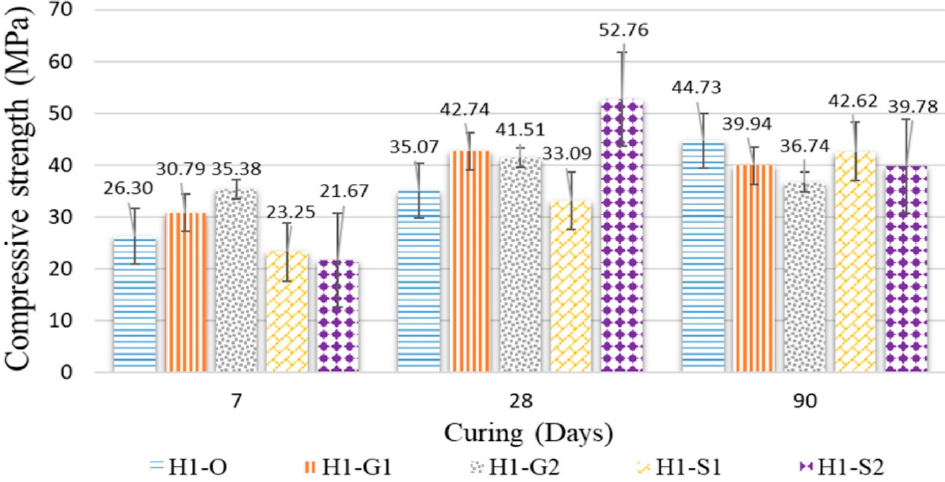
Figure 5. Compressive strength results for H1 high-strength pervious concrete specimens.